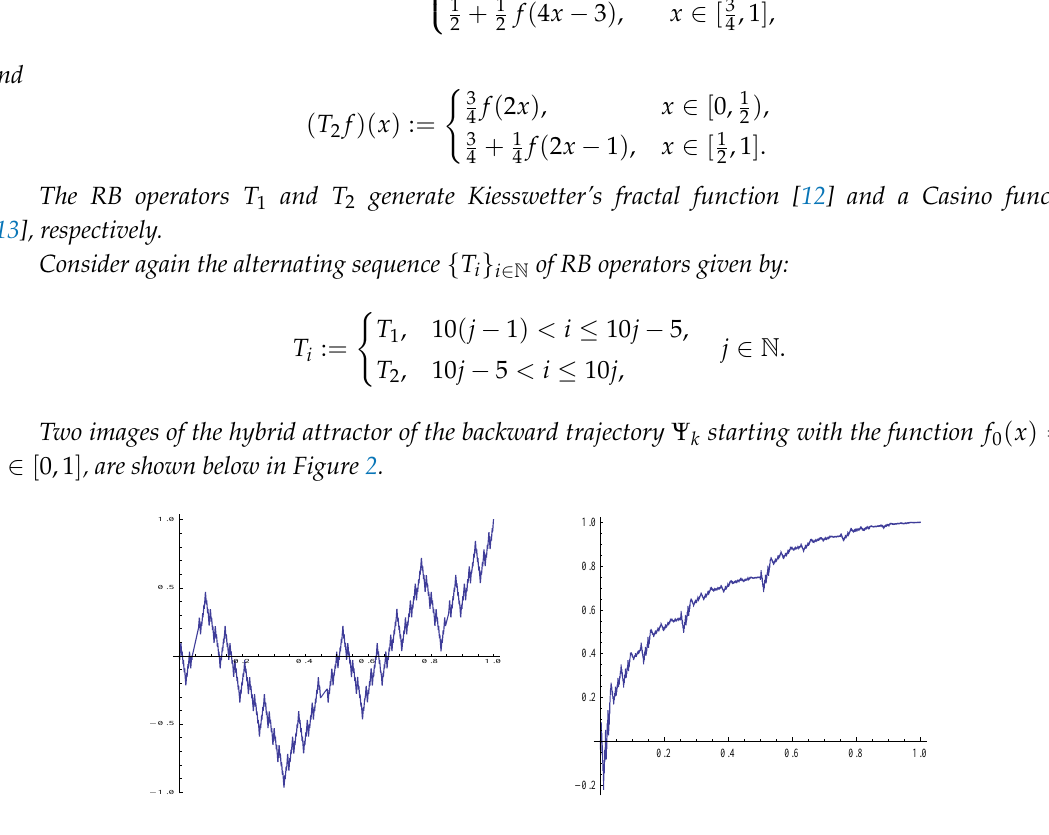
Figure 2. The hybrid Kiesswetter–Casino attractor. The graph of the Casino function ( Right ) contains at the fine scale images of the Kiesswetter function ( Left